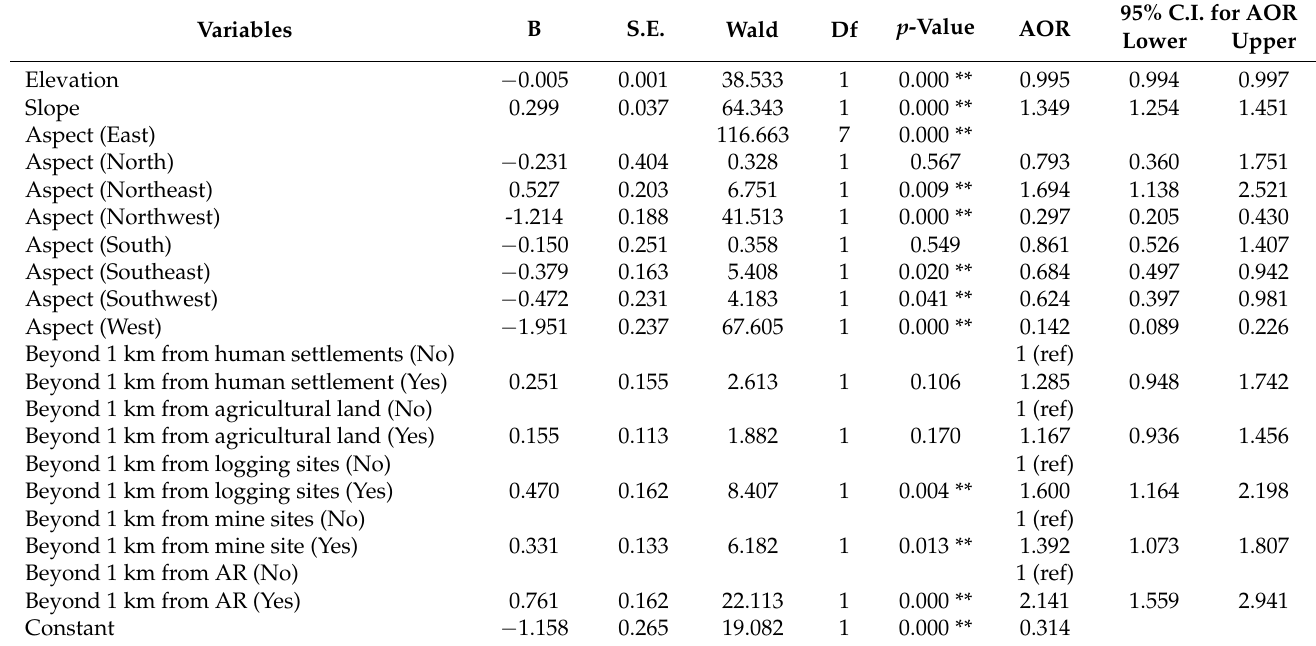
Table 2. Land use and terrain variables associated with the occurrence of core forest